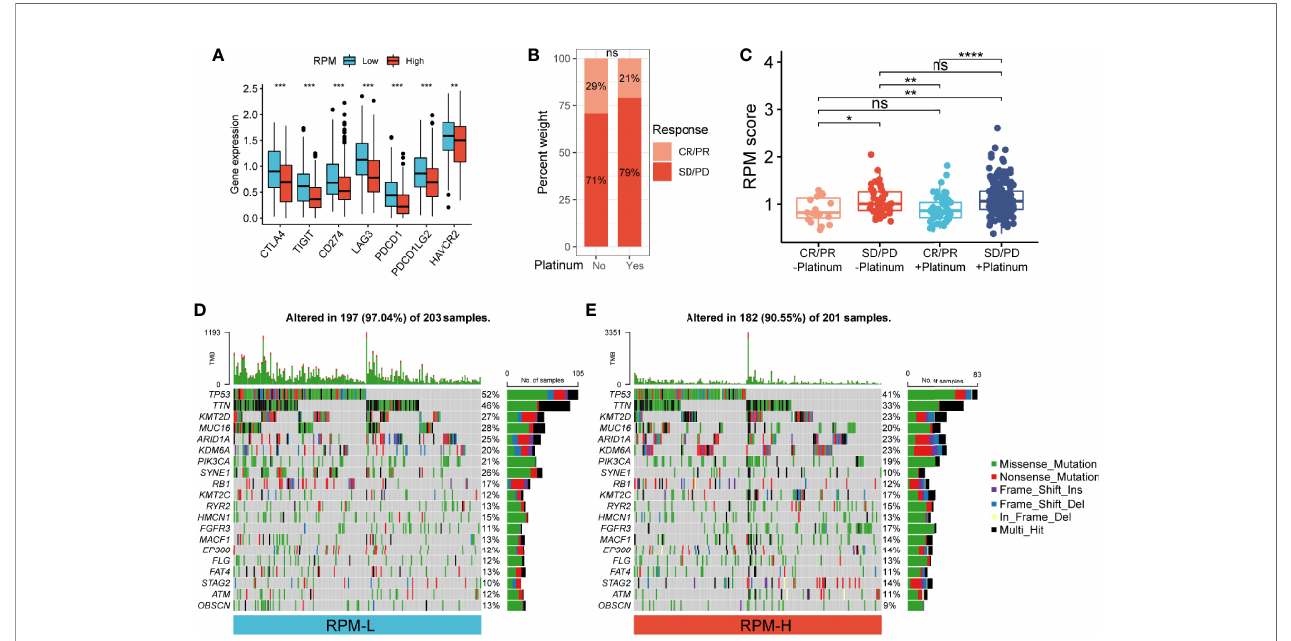
FIGURE 5 | Correlation of RPM with immune checkpoints, platinum-based chemotherapy, and somatic mutation. (A) RPM-L group had signi fi cantly higher expression levels of immune checkpoint molecules compared to those in the RPM-H group. (B) Immunotherapy response in patients who received platinum-based chemotherapy and those who did not. (C) RPM score in CR/PR and SD/PD groups with or without platinum-based chemotherapy. (D, E) Somatic mutation landscape of the 20 most frequently mutated genes in RPM-L (D) and RPM-H (E) groups in TCGA-BLCA cohort * P < 0.05, ** P < 0.01, *** P < 0.001, **** P < 0.0001; NS, nonsigni fi cant. RPM, risk prediction model; CR, complete response; PR, partial response; SD, stable disease; PD, progressive disease; TCGA, The Cancer Genome Atlas; BLCA, bladder